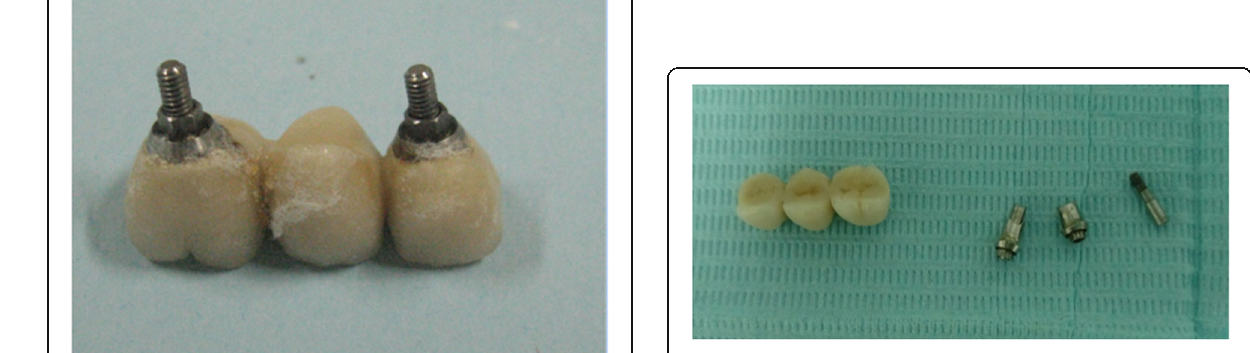
Fig. 3 Abutments and screws completely separated from the